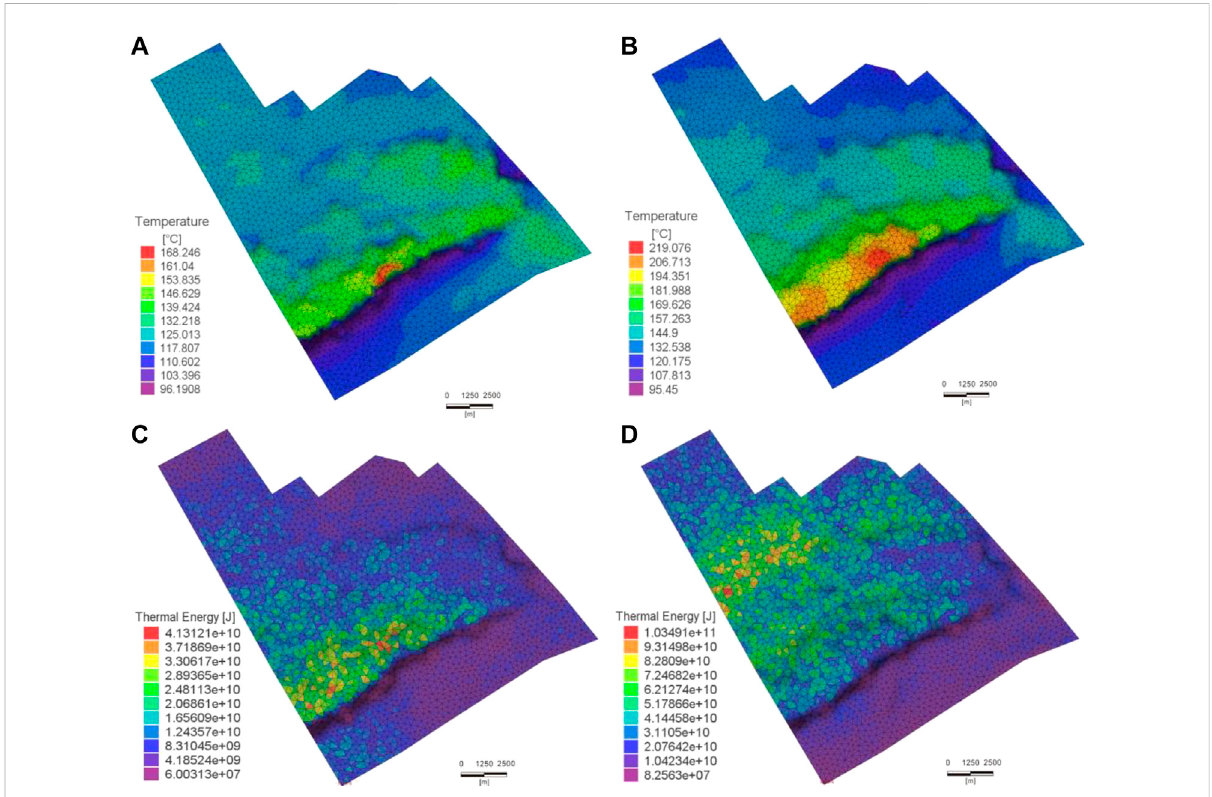
FIGURE 8 (A) ThetemperaturedistributionofthebottomofWeizhouFormation, (B) ThetemperaturedistributionofthebottomofLiushagangFormation, (C) The thermal energy of the bottom of Weizhou Formation and (D) The thermal energy of the bottom of Liushagang